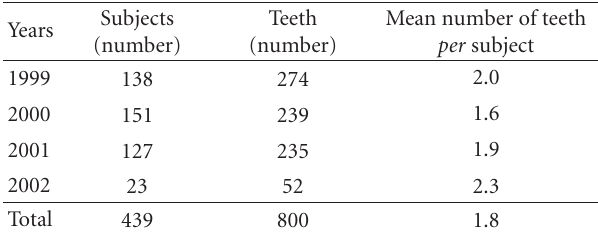
Table 1: Data collected for the study in di ff erent years.